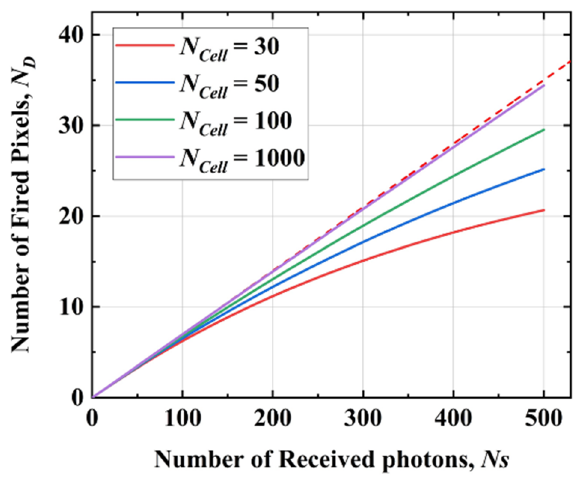
Figure 1. The mean number of fired pixels, N D , versus the mean number of received photons, N S , with different number of pixels in SiPM, N Cell .